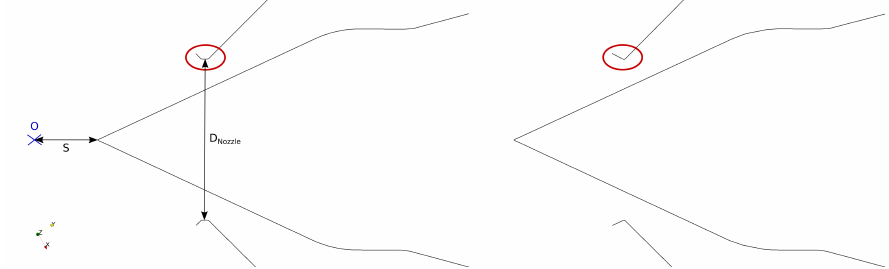
Figure 1. ( Left ): original geometry of the nozzle. ( Right ): modified geometry of the